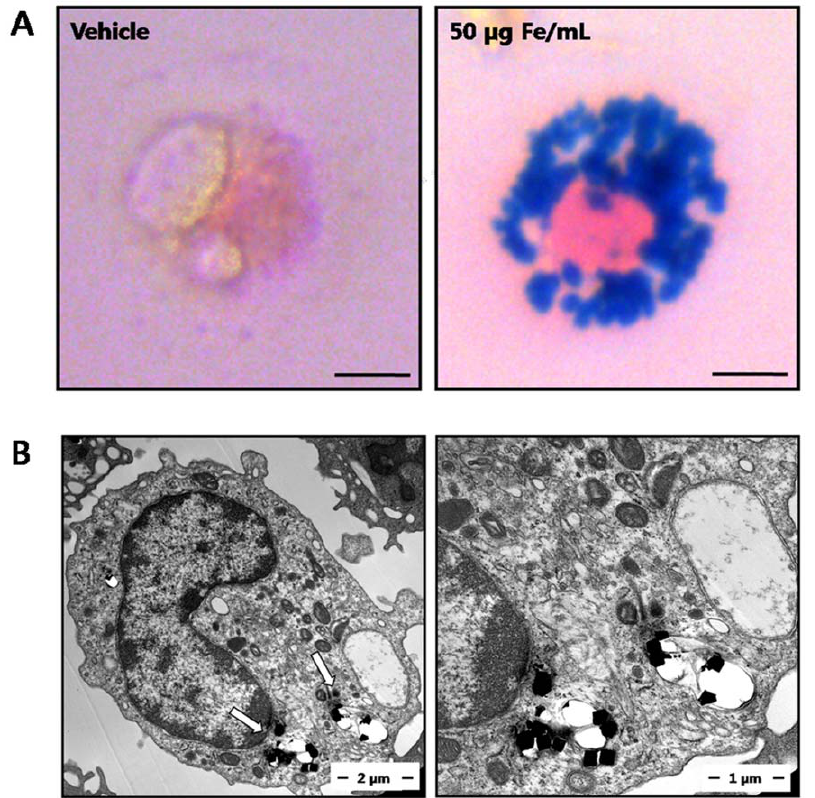
Figure 2. The identification of the intracellular distribution of FIONs in macrophages. (A) Microscopic view (400 6 ) of macrophages treated with FIONs (50 m g Fe/mL). The ingested FIONs were visualized by Prussian blue staining (left: phase, right: Prussian blue). (B) The location of the FIONs was further confirmed by electron microscopy (left: 15000 6 , right: 30000 6 ), which revealed that the ingested FIONs were located in cytoplasmic organelles (arrows).